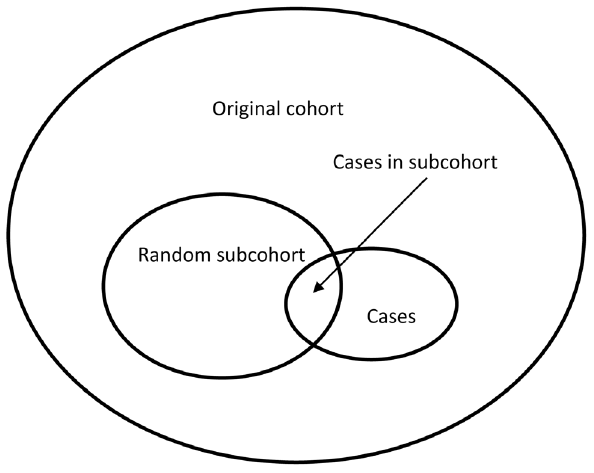
Figure 1. Pictorial representation of an unstratified case-cohort study design. Included in the study are a subcohort of individuals randomly sampled from the original cohort, together with all incident cases of the disease of interest. Because the subcohort is a random sample from the whole original cohort, it includes some incident cases. The subcohort sampling fraction is the proportion of individuals in the original cohort who are included in the random subcohort, and is defined at the start of the